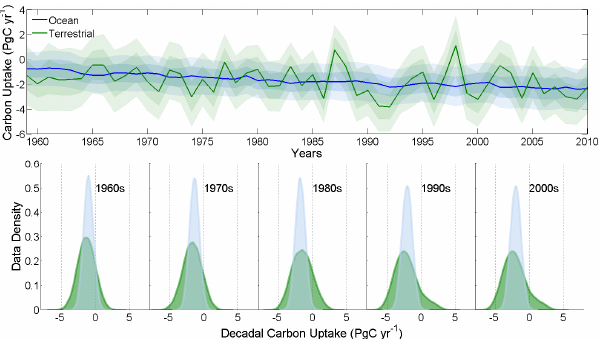
Figure 9. Trends in global carbon uptake by the land and ocean: both the land (green line) and ocean (blue line) show increasing car- bon uptake over the last 50 years, as evidenced by increasingly neg- ative uptake values (top panel); confidence intervals represent the 1 σ (dark transparent) and 2 σ (light transparent) distribution about the mean values for the land (green line) and the ocean (blue line). Kernel density functions for the distribution of uptake by the land (green) and ocean (blue) by decades (bottom panel) showing the in- crease in C uptake by decade but also the increase in variance for land C uptake. See Supplement, Table 2, for ocean and terrestrial C uptake values and their